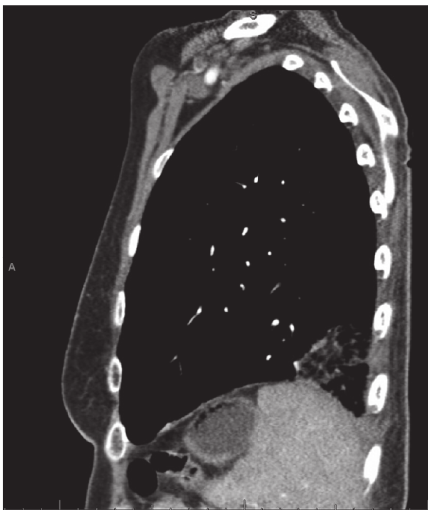
Figure 2: Chest CT scan of case 2 showing pulmonary embolism.